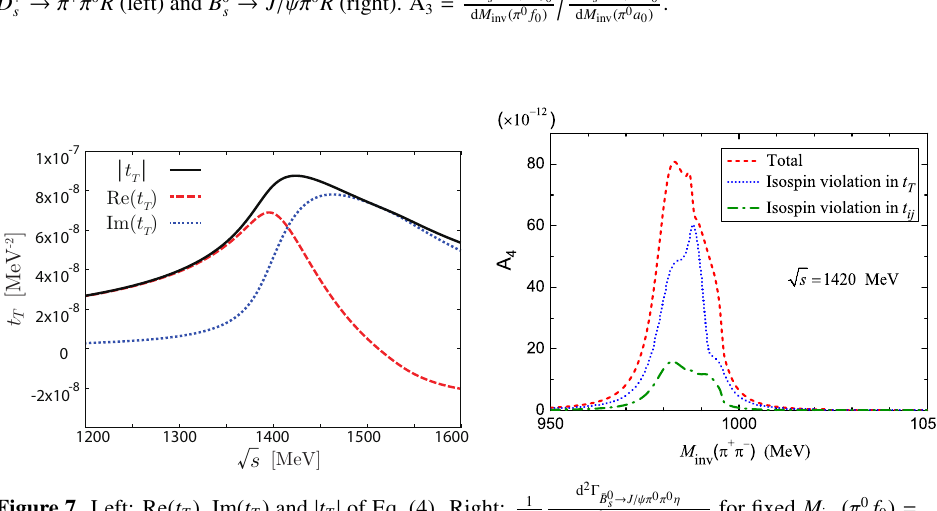
→ J /ψπ 0 R (right). A s